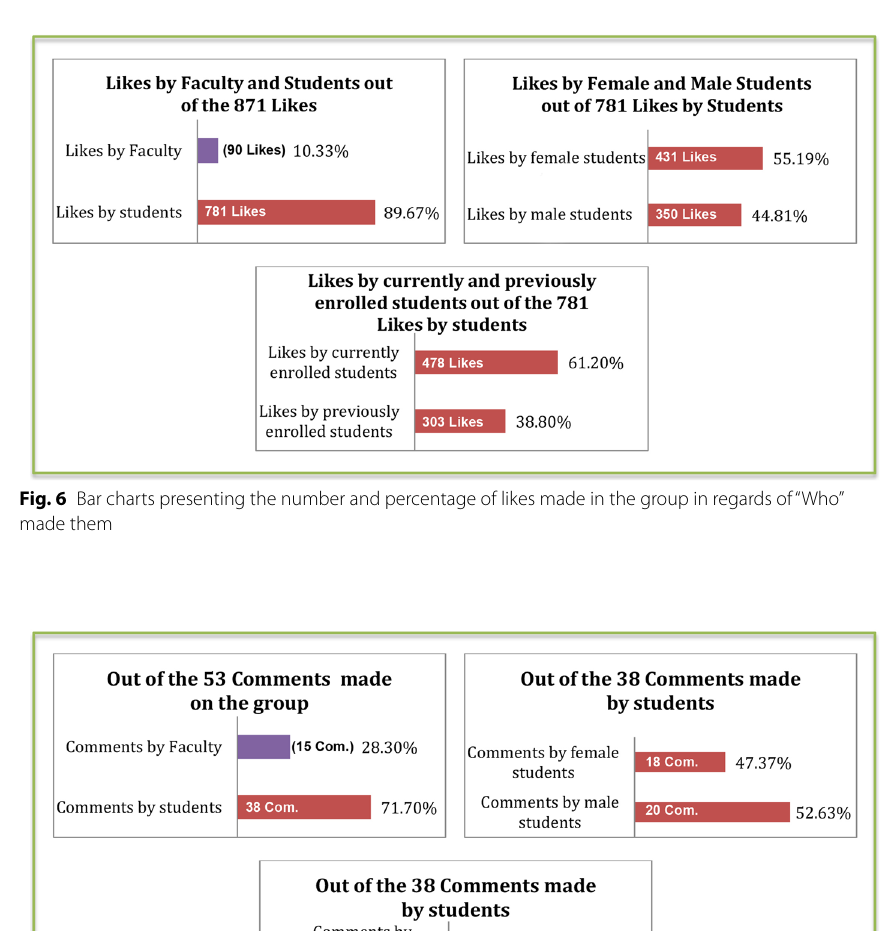
and total number of comments; X 2 (11)